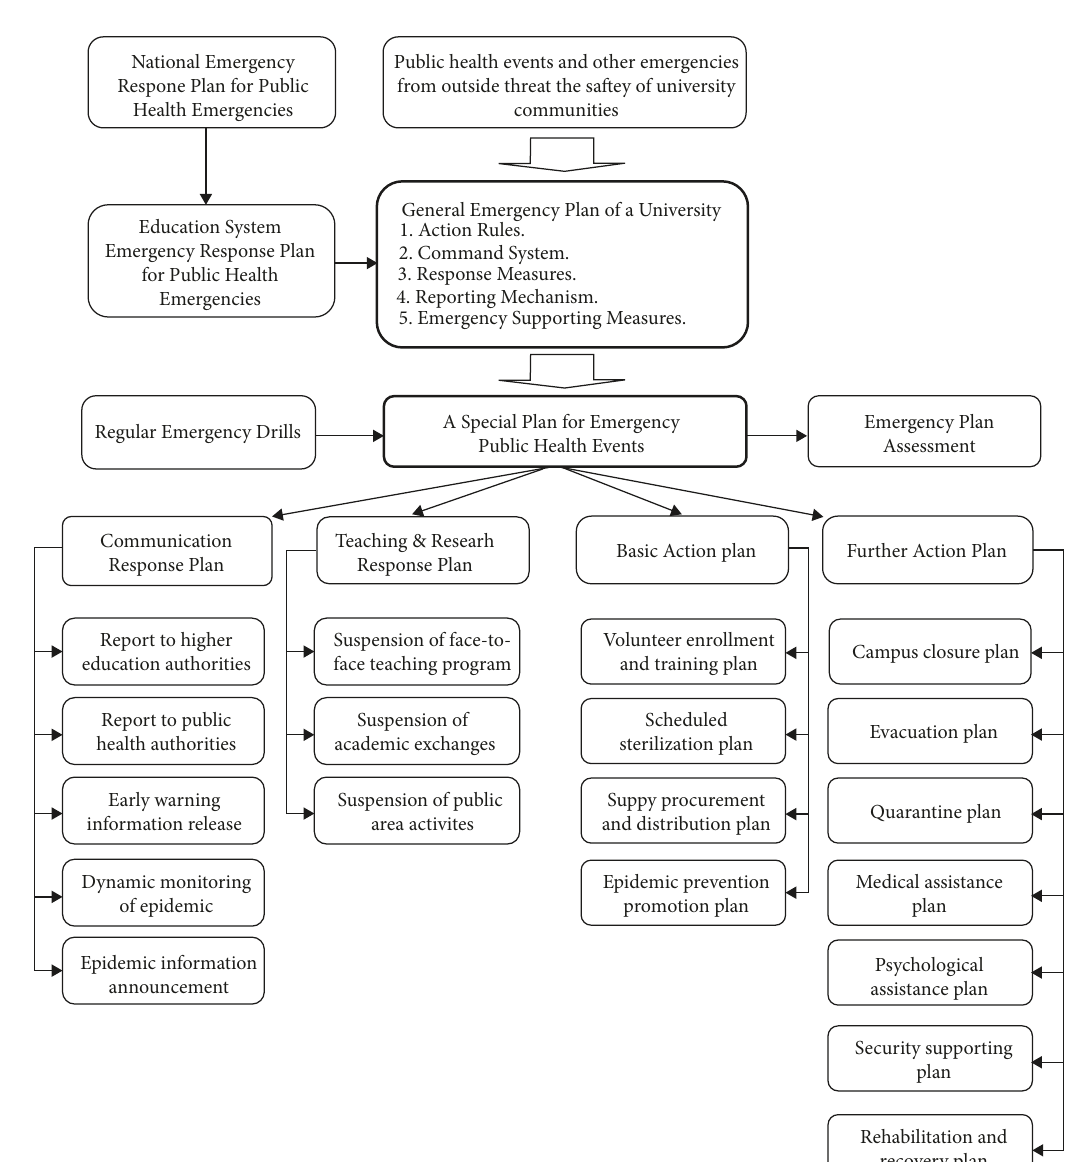
Figure 10: The framework of the emergency management system in